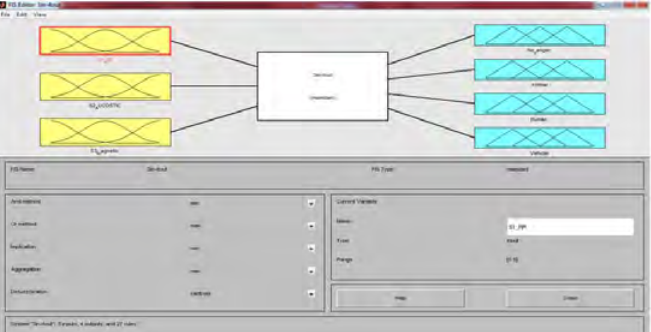
Figure 5. Three inputs and four outputs the fuzzy system controller.